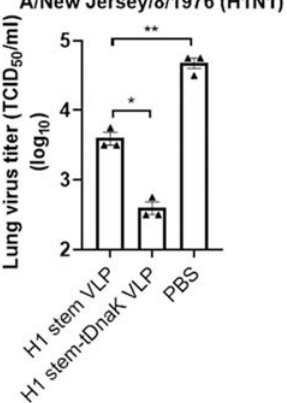
Figure 7. The determination of lung viral load after the sublethal infection. The purpose of the infection experiment is to compare the in vivo protectiveness among vaccination groups; the sublethal dose of mouse-adapted NJ76 was employed for infection for the consideration of lab-animal welfare. Mouse lung samples ( n = 3 per group) were collected on day 4 post sublethal-dose infections with 1 × LD 50 NJ76 H1N1 virus. Viral titers are expressed as TCID 50 /mL. The bars present the mean value ± standard deviation. Each symbol represents the average virus titer of the parallel samples from each mouse. Statistical significance was analyzed by t -test. * represents p < 0.05, and ** represents p < 0.01.